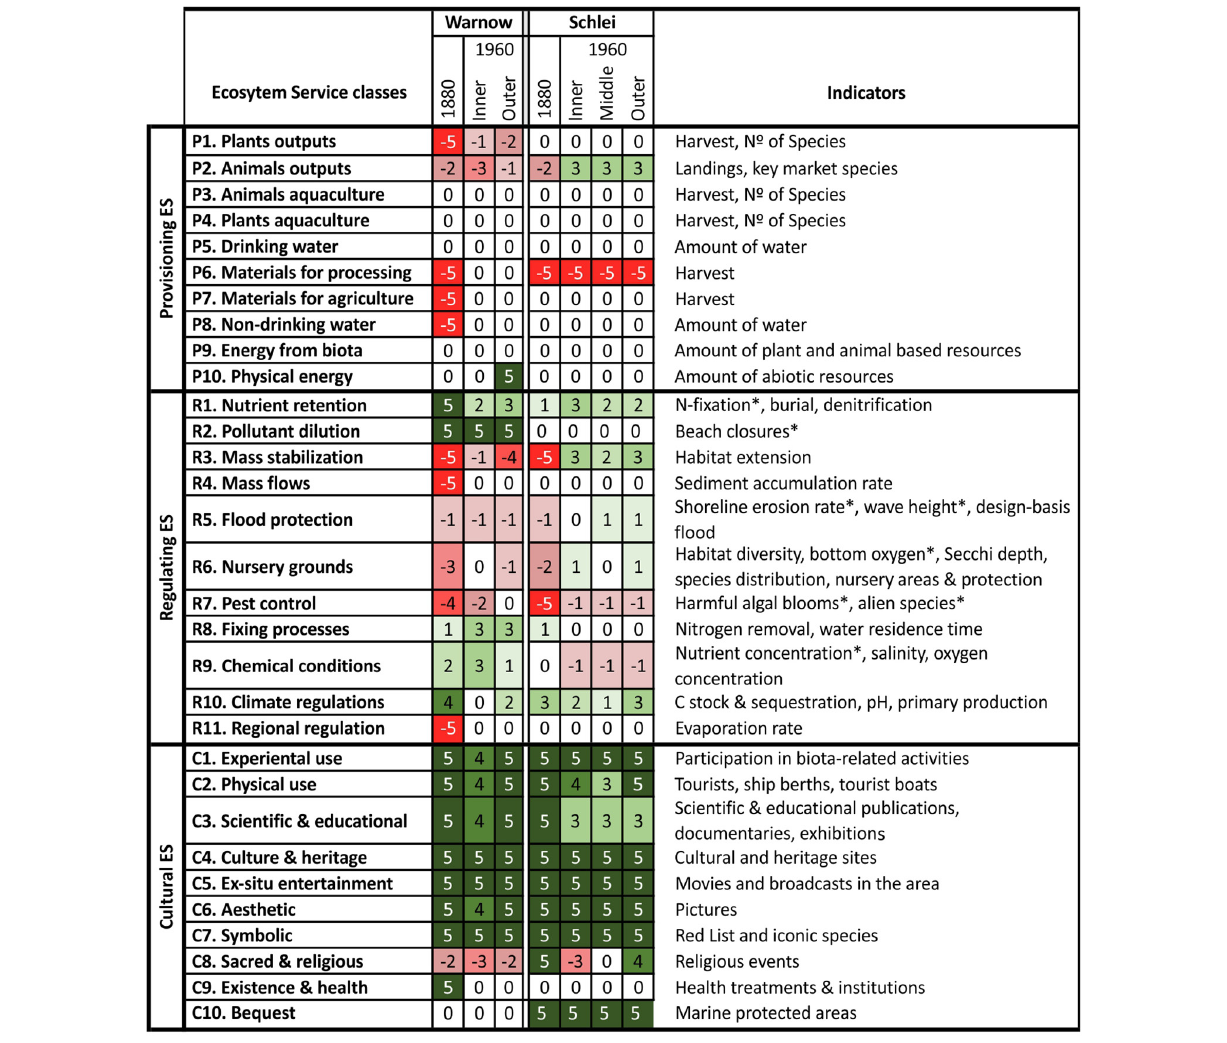
FIGURE 4 | Ecosystem service (ES) classes and underlying indicators based on CICES (Haines-Young and Potschin, 2013, 2018) and MAES (Maes et al., 2016) and the assessment for Schlei and Warnow estuaries (Northern Germany). The assessments compare the ES provision between 1880 (high ecological status according to the WFD) and today for the entire estuary, as well as between 1960 (good ecological status according to the WFD) and today separated into the WFD water bodies. Positive scores indicate an increase in ES provision today ( Figure 3 ). The asterisk ( ∗ ) points out indicators where a decrease in the value was interpreted in the sense of an increase in ES